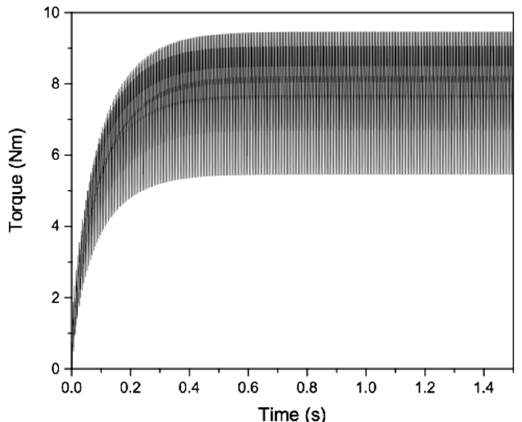
Figure 11. Output torque of the proposed brushless WRSM.